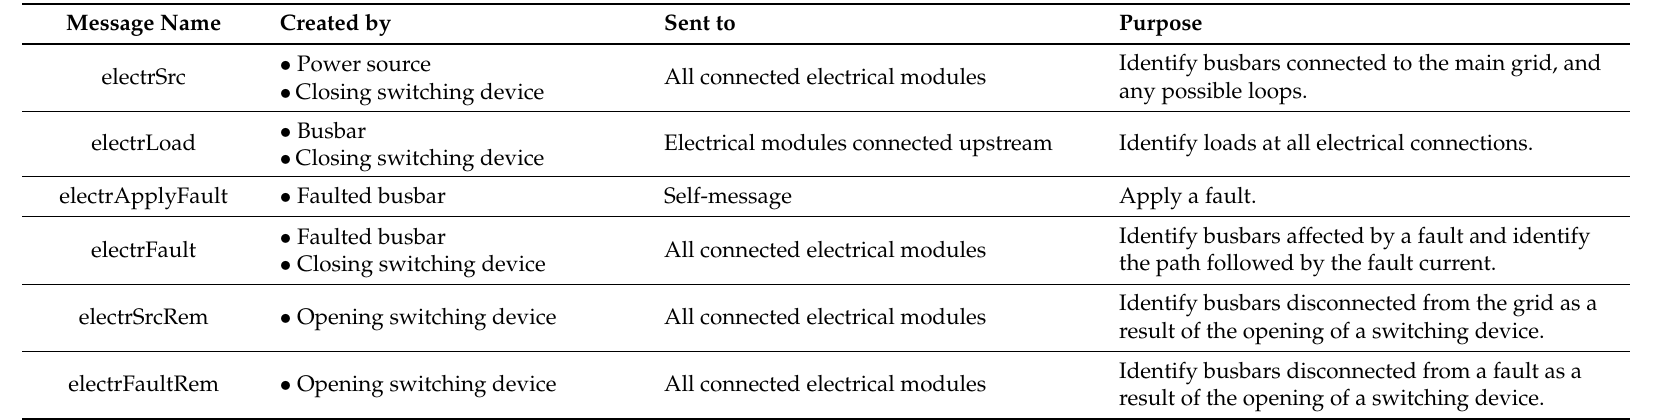
Table 2. OMNeT++ messages used to calculate the status of the electrical